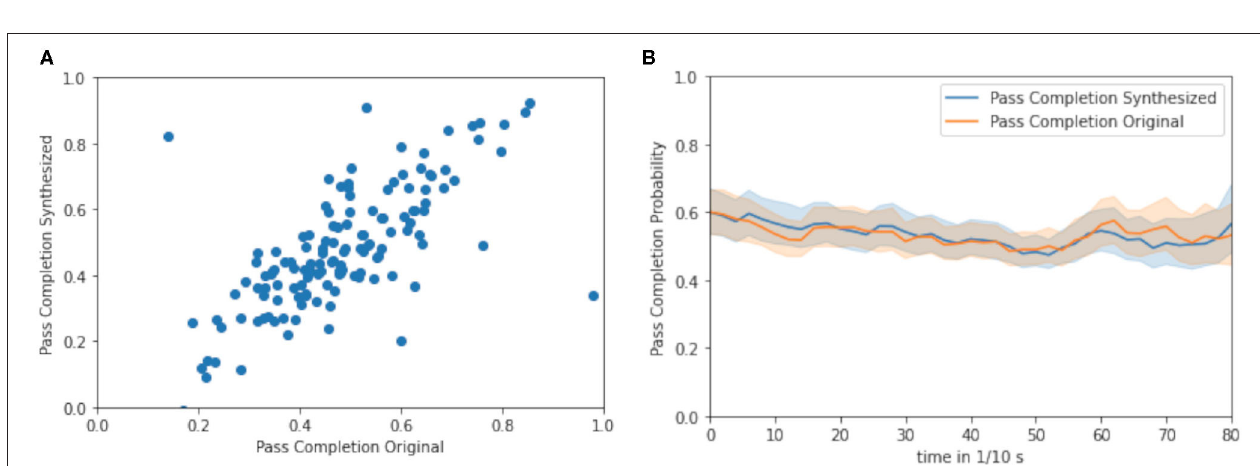
FIGURE 7 | (A) Pass completion probability for synthesized trajectories and true trajectories at the time when the quarterback throws the forward pass (R: 0.545) (B) Average pass completion over time between synthesized (blue) and true trajectories (orange) of defensive players.